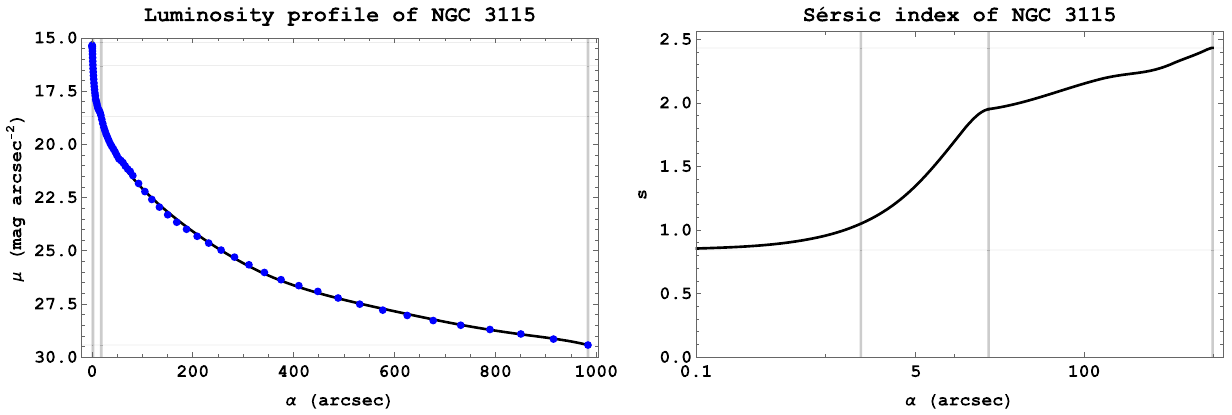
Fig. 9 The line in the left-hand graphics shows the adjusted luminos- ity profile of NGC 3115, and the dots correspond to the values listed by Capaccioli [38]. The right-hand side graphic shows the adjustment obtained using eighth- and seventh-order polynomial approximations for the Sérsic index in the bulge and disk regions, respectively. The